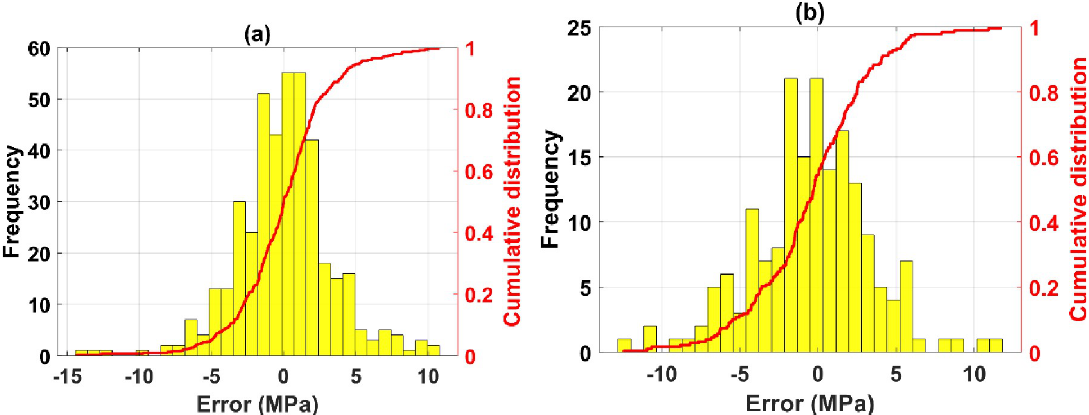
Fig 9. Experimental and predicted shear strength results in the function of sample index for the training and testing datasets.